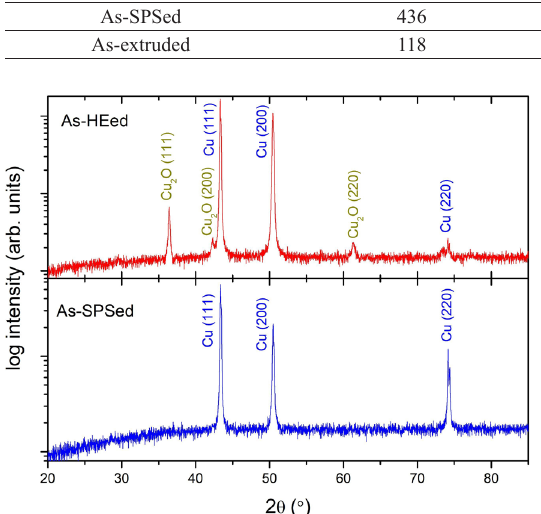
Table 2. Crystallographic parameters of as-SPSed and as-extruded copper samples from XRD analysis. Samples